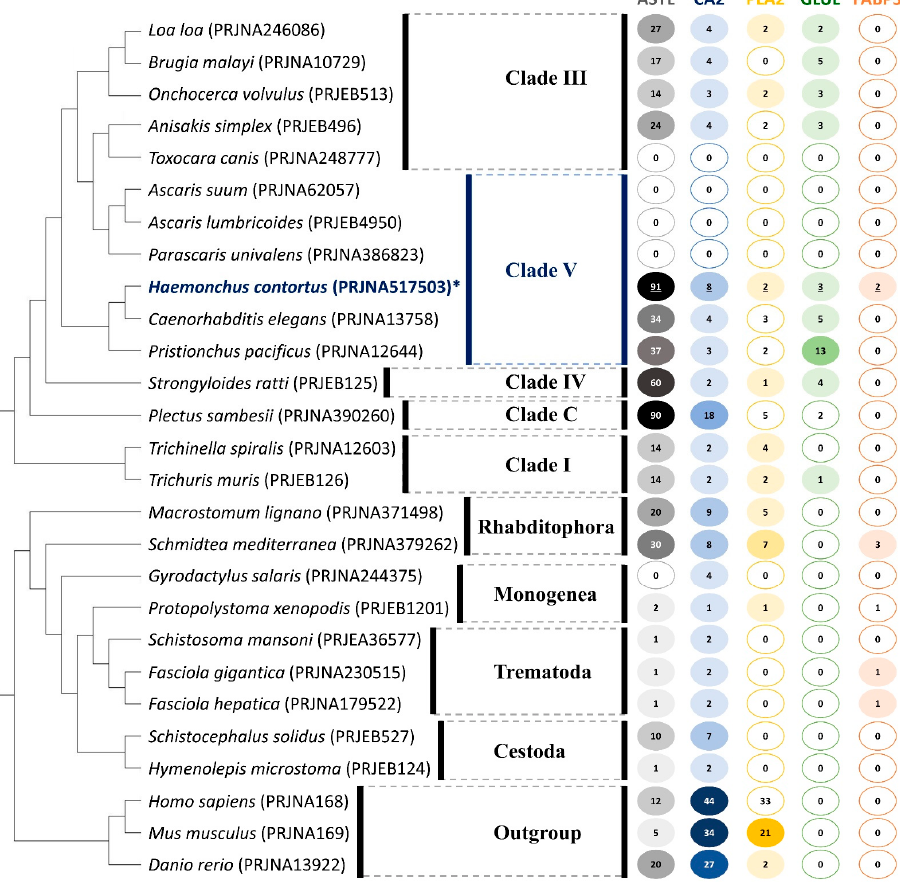
Figure 5. Phylogenetic species tree reconstruction of homologous gene families corresponding to the five DEGs of interest across 27 species. The consensus tree is based on the losses and gains of orthologous groups corresponding to the protein sequence alignments of the five target DEGs of H. contortus : ASTL, CA2, PLA2, GLUL, and FABP3 (labelled with *). The numbers in colored circles represent the total number of gene families corresponding to a particular gene based on orthology. A missing value indicates the absence of an orthologous group corresponding to any of the five target DEGs of H. contortus . Bioproject GenBank accession numbers are provided (in parentheses) for all reference sequences. The five preselected parasite proteins of interest were modeled using the ICM-Pro modelling suite (https://www.molsoft.com/icm_pro.html (accessed on 12 August 2019)) to produce tertiary structures of the Haemonchus enzymes to elucidate any unique second- ary structural motifs and active site compositions (Figure 6 and Table S5). Overall